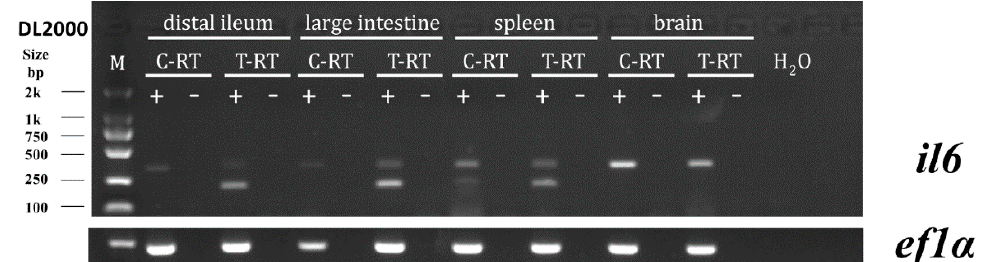
Figure 6. Semi-quantitative RT-PCR results of psIL6 and psIL6ns expression in the brain, spleen, distal ileum, and large intestine after oral administration of A. hydrophila. ef1 α was chosen as the reference gene. C-RT: PBS-treated turtle; T-RT: A. hydrophila treated turtle. + represents the addition of reverse-transcriptase when running the reverse-transcription; —represents the replacement of reverse-transcriptase with H 2 O when running the reverse-transcription. H 2 O means the template was H 2 O.